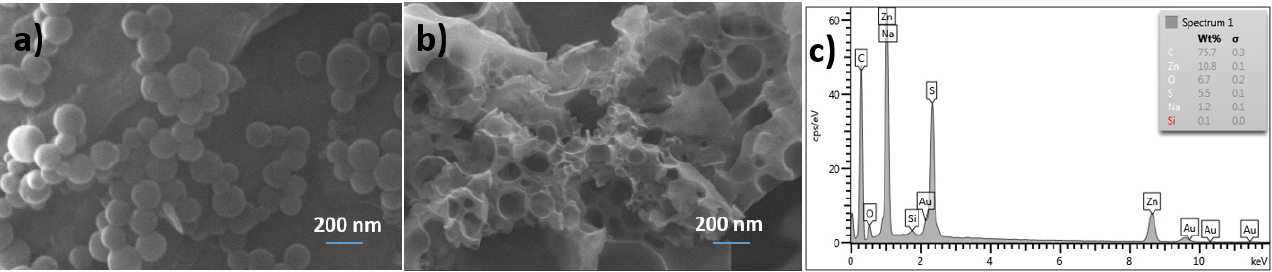
Figure 3. FT-IR spectrum of ( a ) PS- b -PMMA, ( b ) PS- b -PMMA- SP and ( c ) PS- b -PMMA- SP -ZnS functionalized block copolymer. The x -axis in the spectrum appears bracket for the sake of simplicity.